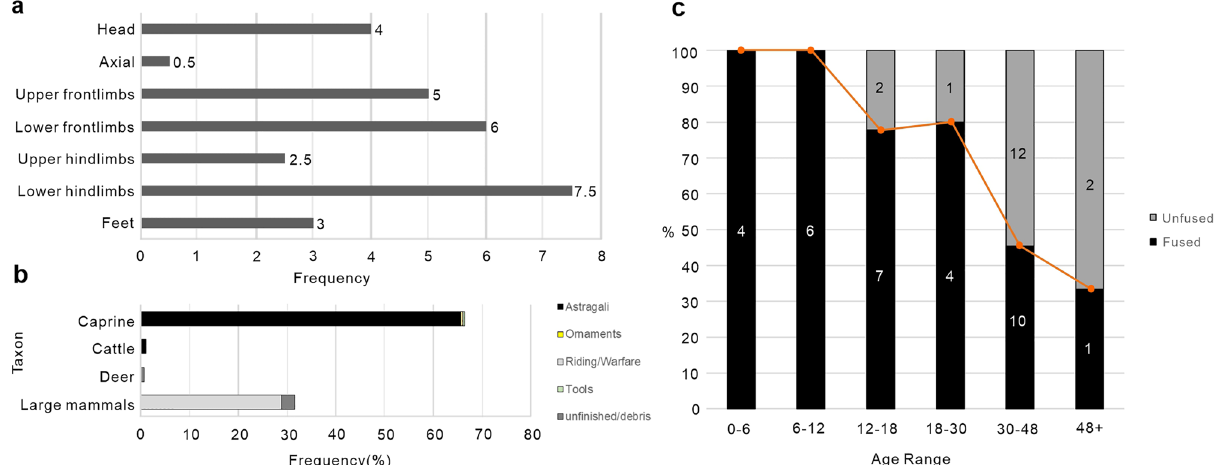
of worked bones per taxa. For data see Tables S2 and S3. ( c ) Caprine survivorship from epiphyseal fusion, using 82 . Age class 0–6 (A) was defined by the fusion staus of the proximal radius (n = 4); Age class 6–12 (B)